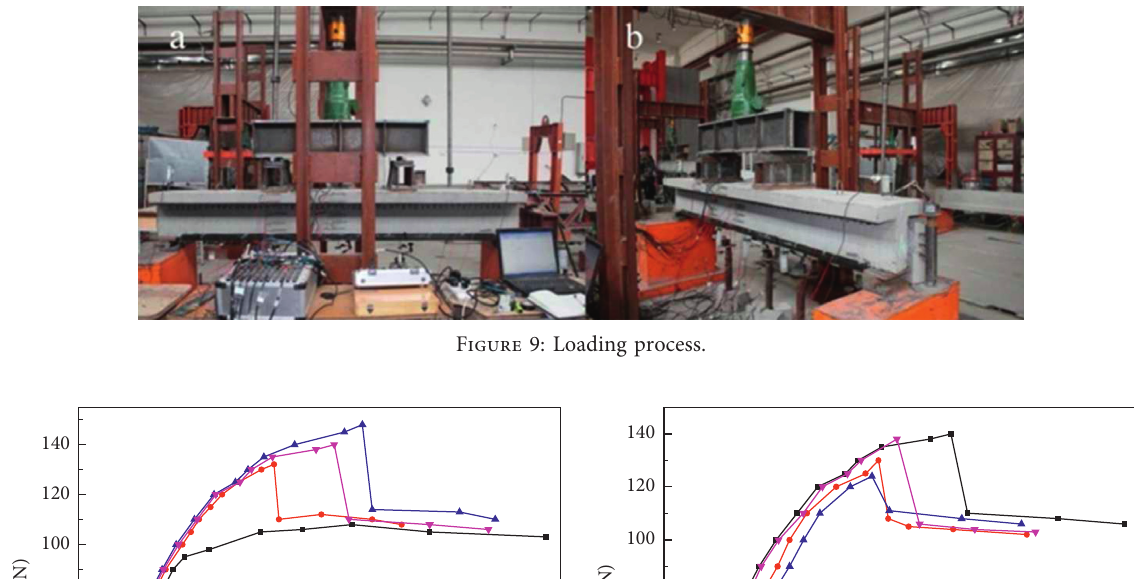
～ L 0 3 . (b) Beam L 3